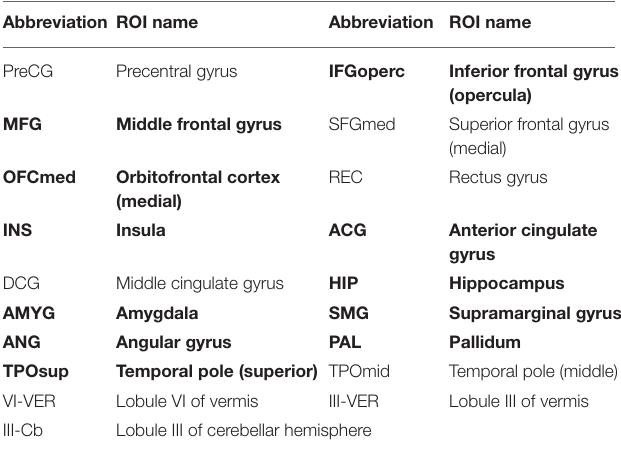
TABLE 6 | ROIs selected from LON , HON-1, and HON-2